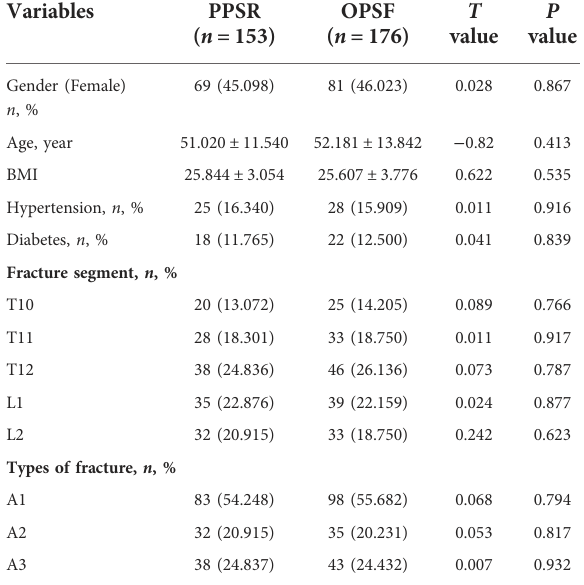
TABLE 1 Demographic and baseline characteristics of the